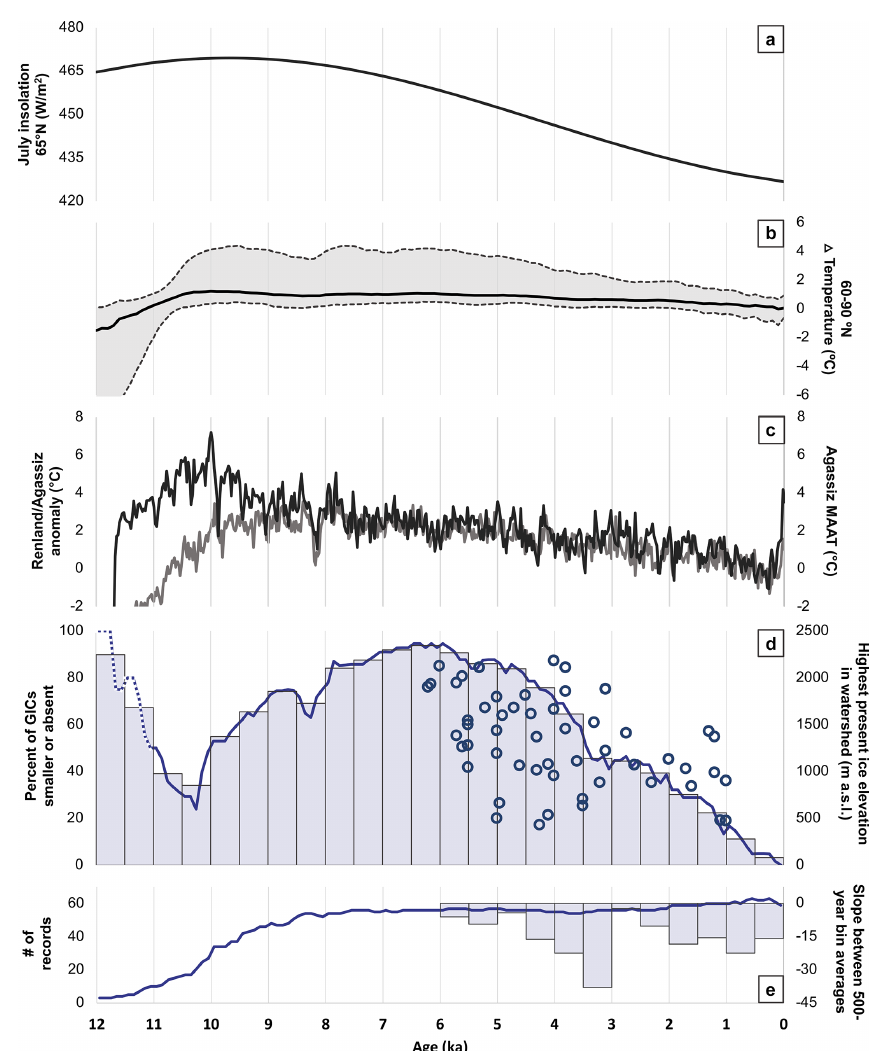
Figure 10. Arctic-wide summary of lake-based GIC records. (a) July insolation at 65 ◦ N. (b) Reconstructed mean annual temperature from the Temperature 12k database for the latitudinal band 60–90 ◦ N, the multi-method ensemble median (solid line), and 5th and 95th percentiles (lower and upper dashed lines). Temperature anomalies are relative to 1800–1900CE (Kaufman et al., 2020). (c) The gray line is a Holocene temperature reconstruction based on elevation-corrected average δ 18 O data from Renland and Agassiz ice cores. Temperatures are 20-year averages given as deviations from a smooth estimate of present temperatures in Greenland (Vinther et al., 2009). The black line is the elevation-corrected Agassiz δ 18 O mean annual air temperature reconstruction (Lecavalier et al., 2017). (d) The line shows the percent of GICs smaller than present or absent from 12 to 0ka, calculated in 100-year bins. The dashed line shows time bins in which a low number ( < 10) of records were available. Bars show 500-year bin averages. Open dots show the timing of earliest GIC regrowth in the middle to late Holocene versus the highest present ice elevation inside the studied lake’s watershed. (e) The line shows the number of records from 12 to 0ka. Bars show the slope between the 500-year bin averages (above) from the middle to late Holocene. More negative slopes indicate time periods with a higher number of GICs